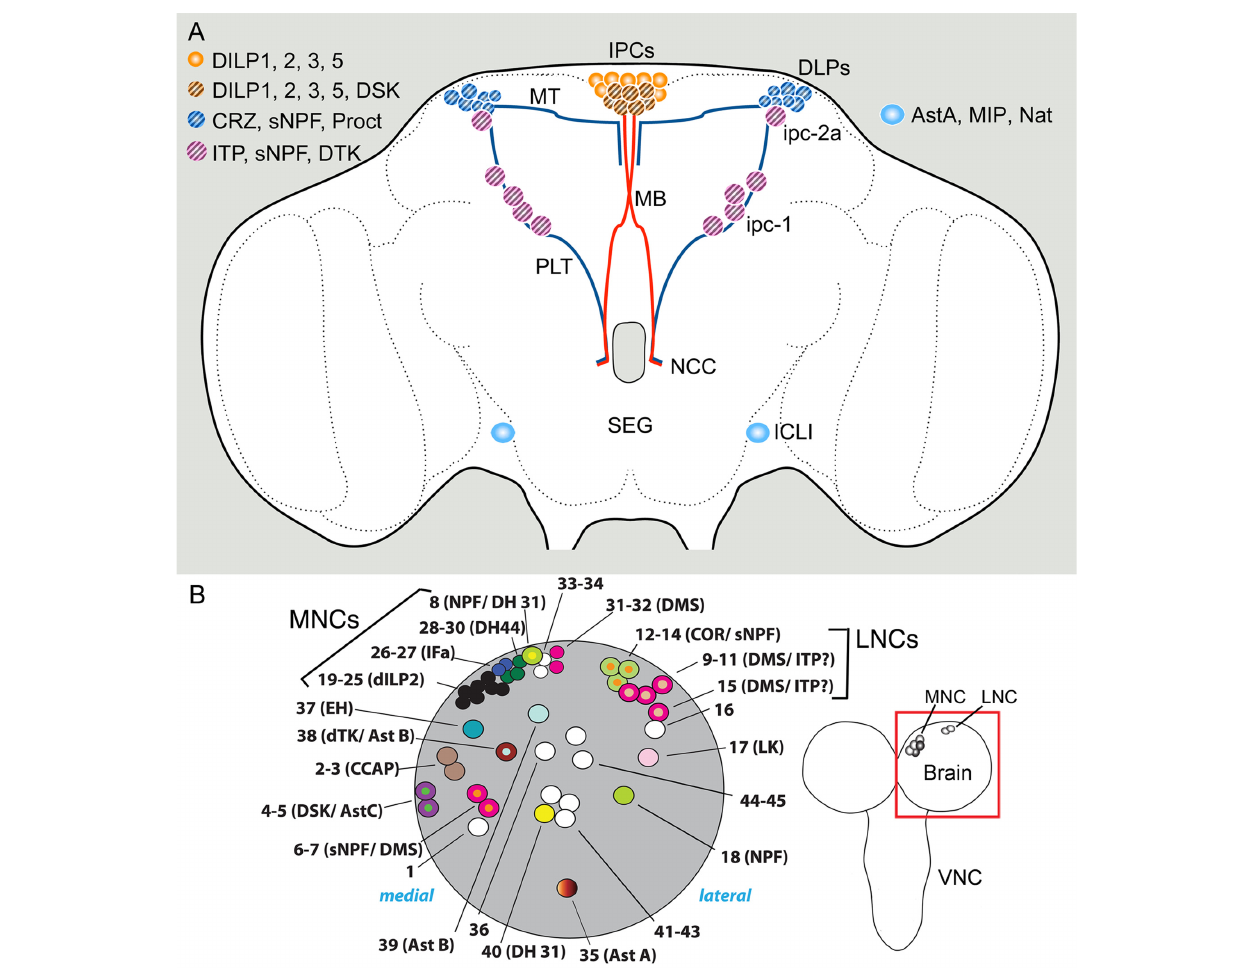
FIGURE 2 | Sets of neuroendocrine cells in the Drosophila brain that express colocalized neuropeptides and peptide hormones. (A) Neurosecretory cells and interneurons of the adult brain. The insulin producing cells (IPCs) co-express DILP1, 2, 3, and 5. Some of the IPCs (cross hatched) also produce drosulfakinins (DSK1 and 2). The IPCs are regulated by DLP neurons that produce short neuropeptide F (sNPF), corazonin (CRZ), and proctolin (Proct) (Kapan et al., 2012). These DLPs are likely to also release CRZ into the circulation via axons passing through the NCC nerves to peripheral release sites in the CC, anterior aorta and intestine (Kubrak et al., 2016). Another set of lateral neurosecretory cells (LNCs), designated ipc-1 and ipc-2a, express the peptides sNPF, tachykinin (TK) and ion transport peptide (ITP) (Kahsai et al., 2010). These neurons, like the DLPs, are parts of the LNC clusters and have axon terminations in peripheral sites overlapping those of the IPCs and the DLPs. A pair of large interneurons in the brain (ICLI) were shown to co-express AstA, MIP and natalisin Diesner et al. (2018). Further abbreviations: MT, medially projecting axon tract; PLT, posterior lateral axon tract; MB, median bundle. This figure is slightly altered and updated from Nässel et al. (2013). (B) Neuroendocrine cells in one hemisphere of the larval brain (dorsal view). The cells shown (numbered 1–43) are Dimmed positive cells, most of which have neuropeptides assigned to them. The bona fide MNCs include cells numbered 19–25, 28–30, and 31–32, the other adjacent neurons are peptidergic interneurons. Note several cases of colocalized peptides, some of which so far have not been observed in the adult brain: NPF/DH31, DMS/ITP, dTK/AstB, DSK/AstC, and sNPF/DMS (acronyms as in text). Left image from Park et al. (2008) with permission (PLOS, Open